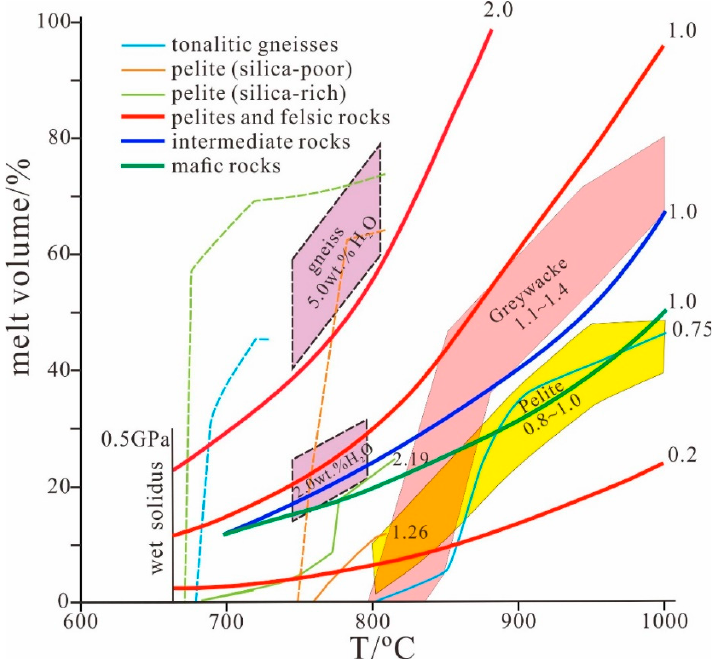
Figure 2. The effect of water on the melt volume derived from partial melting of crustal rocks. The number represents the water content (wt.%) for the whole rock. The thick line shows the melt vol- ume as a function of temperature and initial water contents of protolith in fluid-absent melting re- actions of some crustal rocks at 0.5 GPa [16,43], which represents the maximum amount of melt derived from the rock’s partial melting. The thin solid line and dashed outline, respectively, show the melt volume as a function of temperature for various H 2 O-absent or H 2 O-present starting com- positions in experiments [81–84].